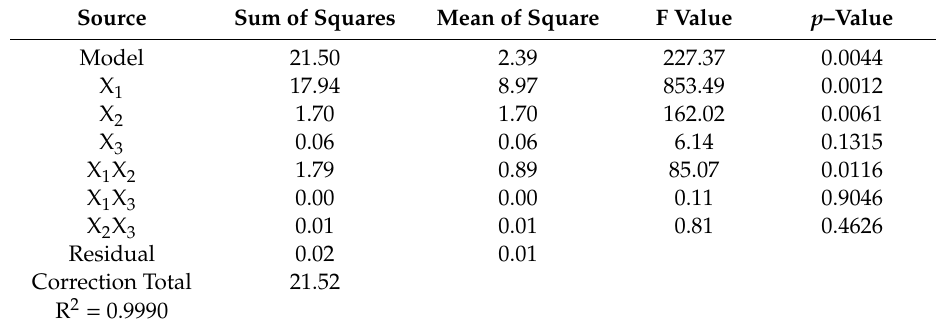
Table 3. ANOVA analysis results of Factorial Design (FD) for yeast and mold count in UV pasteurization process (log CFU /